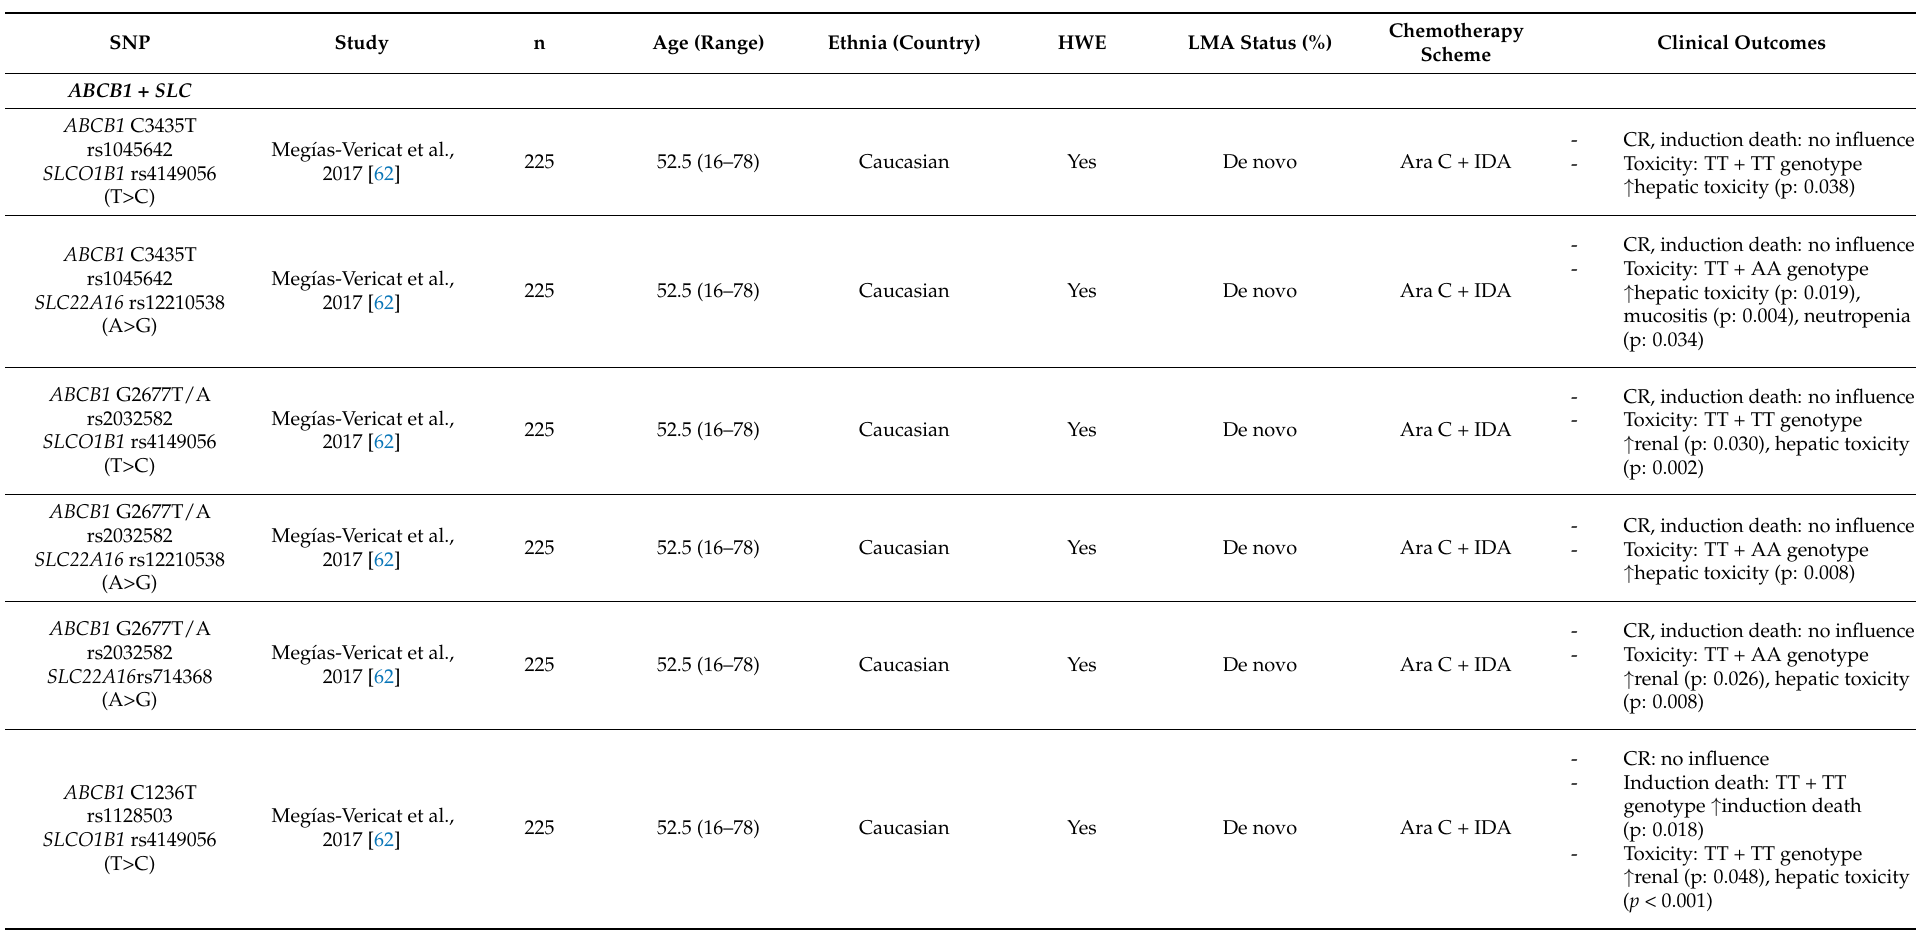
Table 3. Characteristics of the studies included in the systematic review for SNP–SNP combinations of ABC and SLC